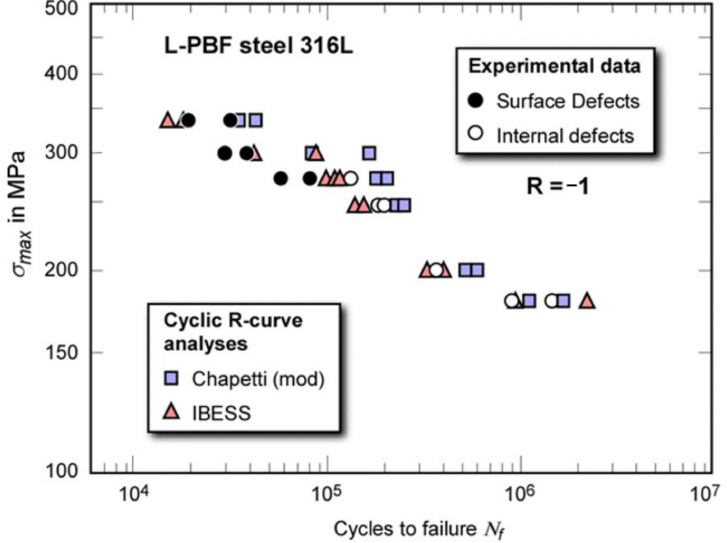
Figure 11. Application of cyclic R curve analyses to the determination of S–N curve data of L-PBF steel 316L according to [47].